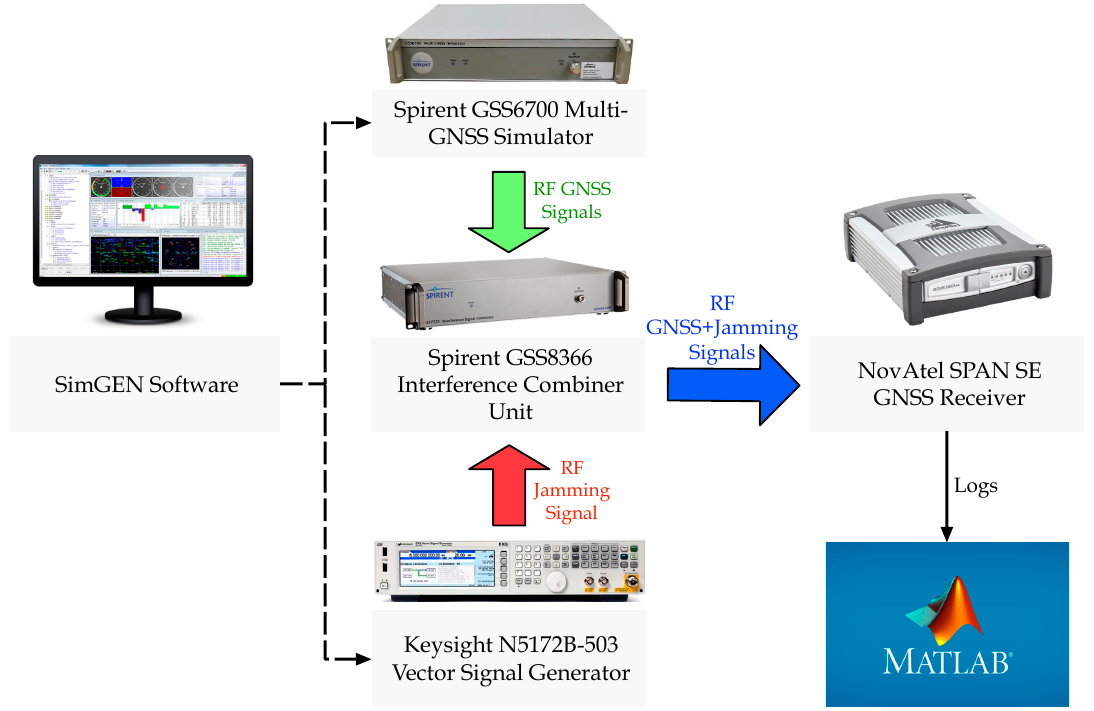
Figure 2. The complete experimental setup.